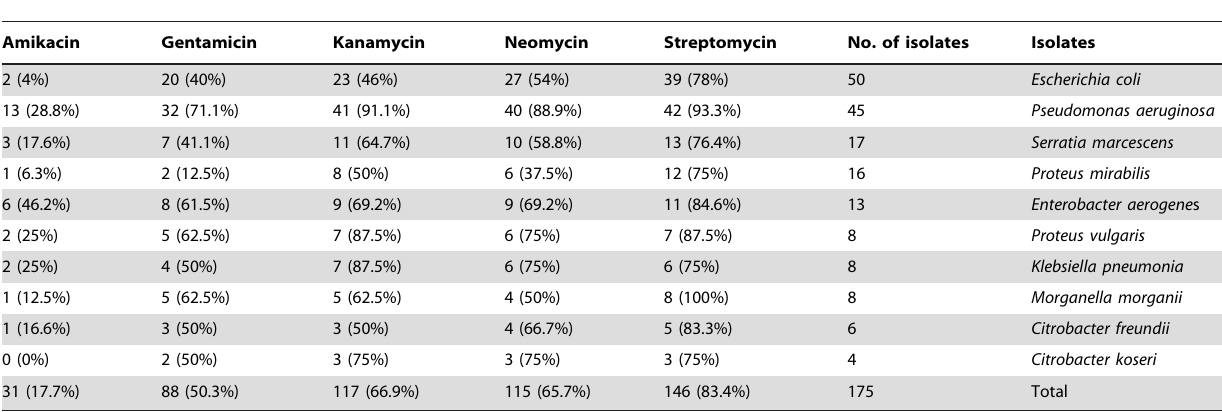
Table 2. Resistance patterns of Gram-negative bacteria to different aminoglycosides (Agar Dilution method).